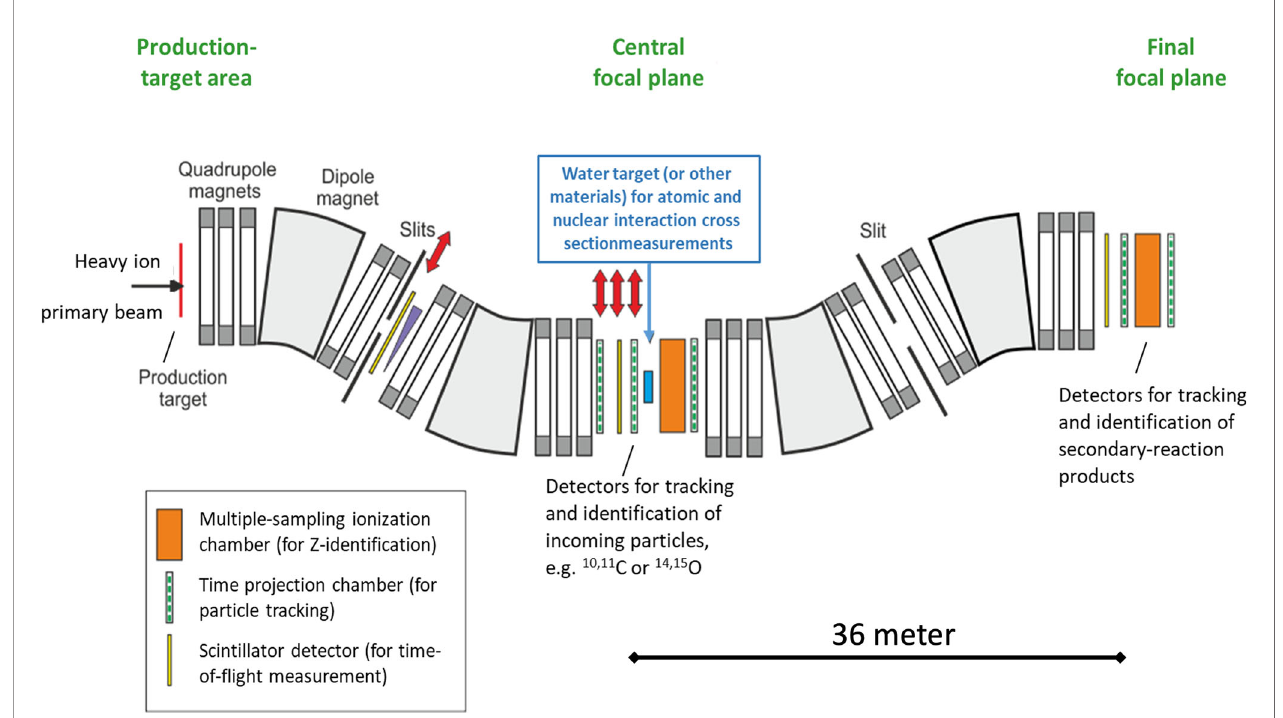
FIGURE 3 | Schematic view of the symmetric FRS branch (projection in the horizontal dispersive plane) and the experimental setup to measure the interaction cross-section and nuclear charge composition of the beam fragmented in water. Red double-sided arrows indicate remotely removable